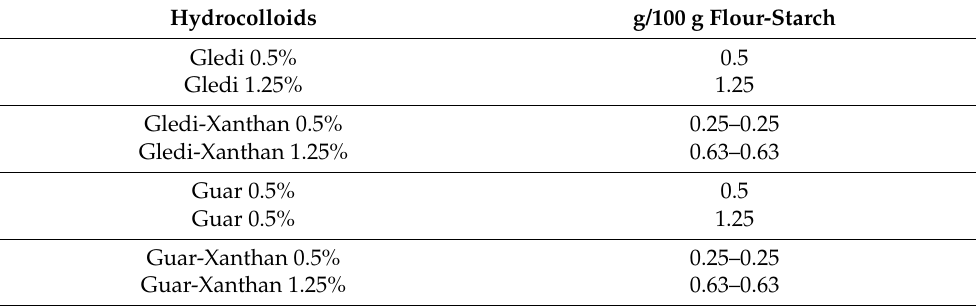
Table 1. Hydrocolloids used for gluten-free